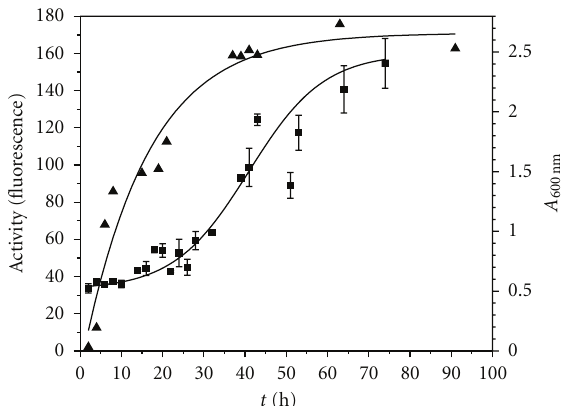
Figure 1: Correlation between growth and the appearance of Bs21- BLIS in the culture medium. Bacterium was grown in tryptic soy broth, and duplicate samples were collected at di ff erent times. One sample was used for measuring the optical density at 600 nm ( (cid:2) ) and the other for evaluating the Bs21 - BLIS activity ( (cid:3) ) against Bacillus cereus employing a fluorogenic rapid method.